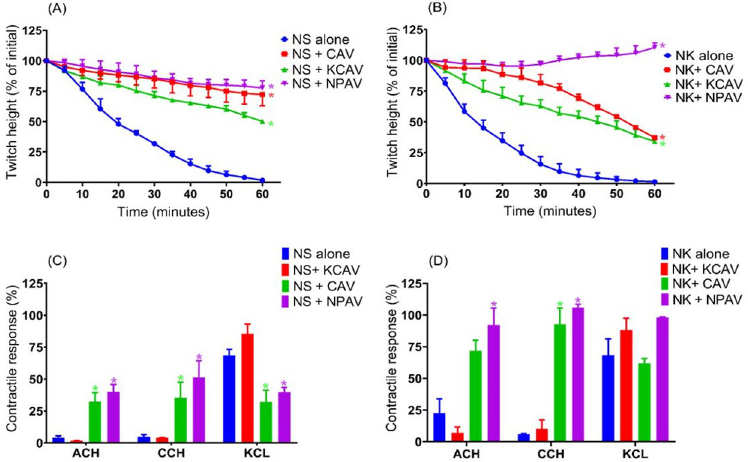
Fig 5. Effect of pre-incubation of antivenoms to indirectly stimulated twitches and contractile responses to exogenous agonists in tissue exposed to Malaysian N . sumatrana and N . kaouthia . Panels (A) and (B) indicate change in twitch height for tissues that were pre-incubated with recommended titer of Cobra Antivenom (CAV), Neuro Polyvalent Antivenom (NPAV) and King Cobra Antivenom (KCAV) and exposed to N . sumatrana and N . kaouthia venoms (5 μ g/ml), respectively. Panels (C) and (D) indicate contractile responses to exogenous agonists in tissues that were pre-incubated with antivenoms after exposure to N . sumatrana and N . kaouthia venoms (5 μ g/ml), respectively. NS indicates N . sumatrana venom and NK indicates N . kaouthia venom. � p < 0.05, significantly different than the respective venom alone (n = 3, one-way